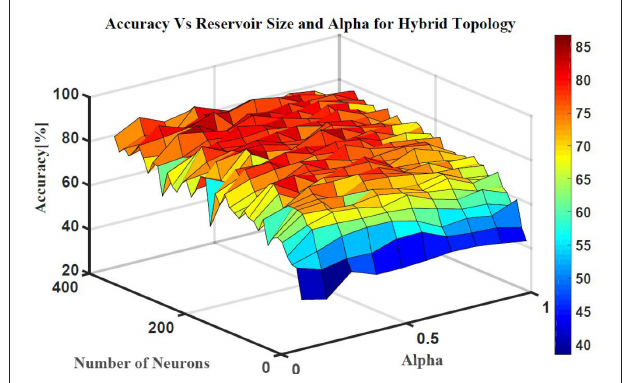
FIGURE 11 | The effects of the number of neurons within the reservoir and alpha on the testing accuracy of finger motion recognition using hybrid topology.